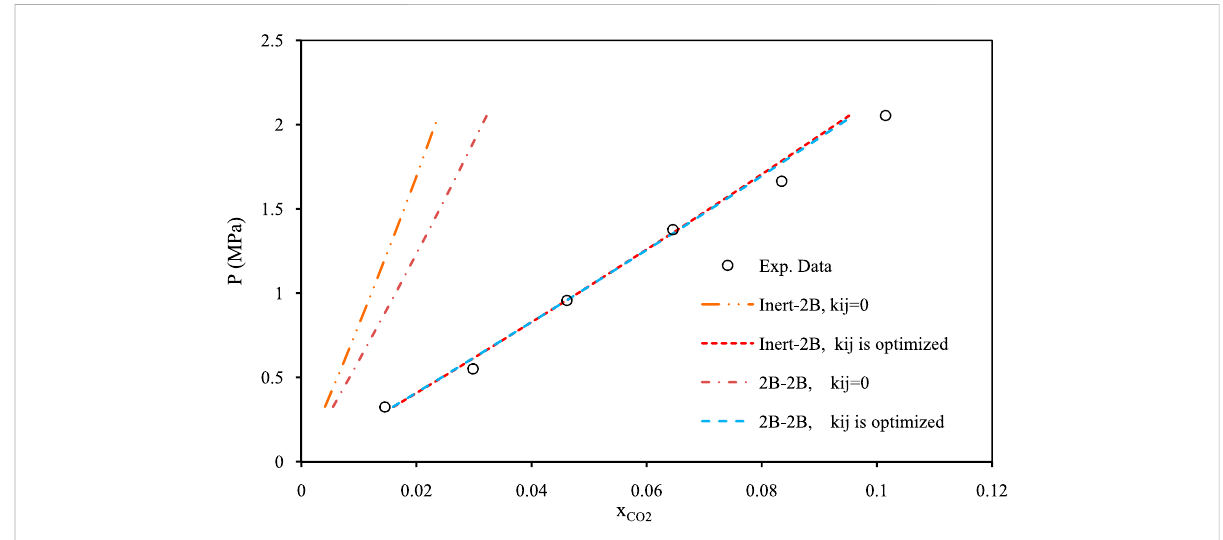
FIGURE 6 Comparison of two association schemes of PC-SAFT (inert-2B and 2B – 2B) for solubility of CO 2 in benzyltriethylammonium chloride + acetic acid (1:2) (Sarmad etal., 2017)atthetemperature of 298.15 K. The pure compoent PC-SAFTparameters ofthe DES wereoptimized using thedensity model of Haghbakhsh et al. (2019).